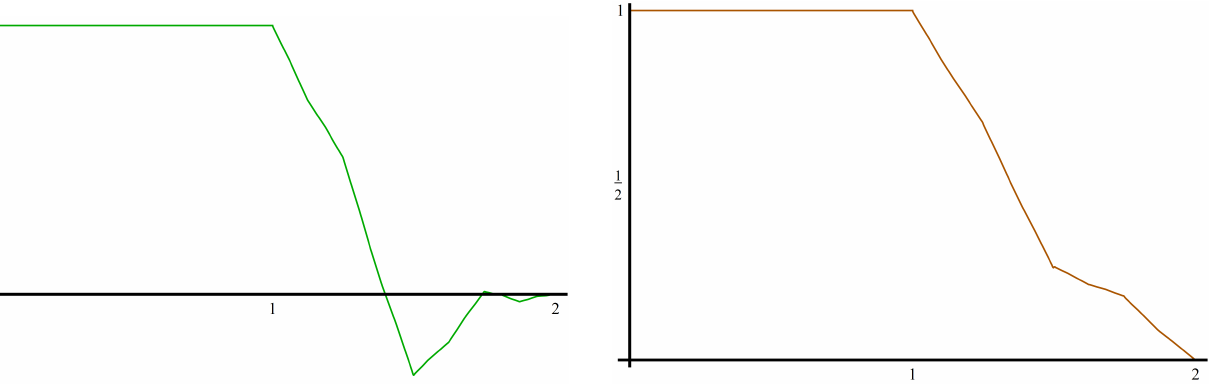
Figure 3. The edge function using φ ( right ) from Example